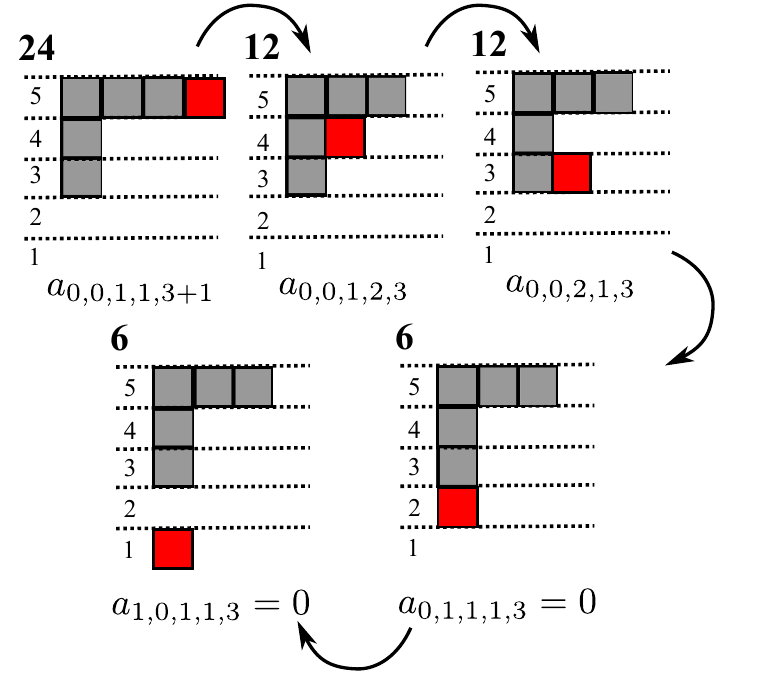
Figure 4 . Example of a tile